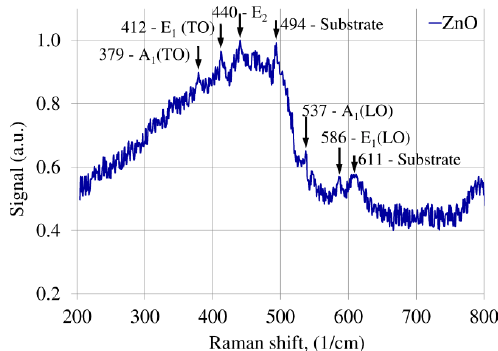
Figure 4. Raman spectra of the ZnO layer deposited on microsphere.